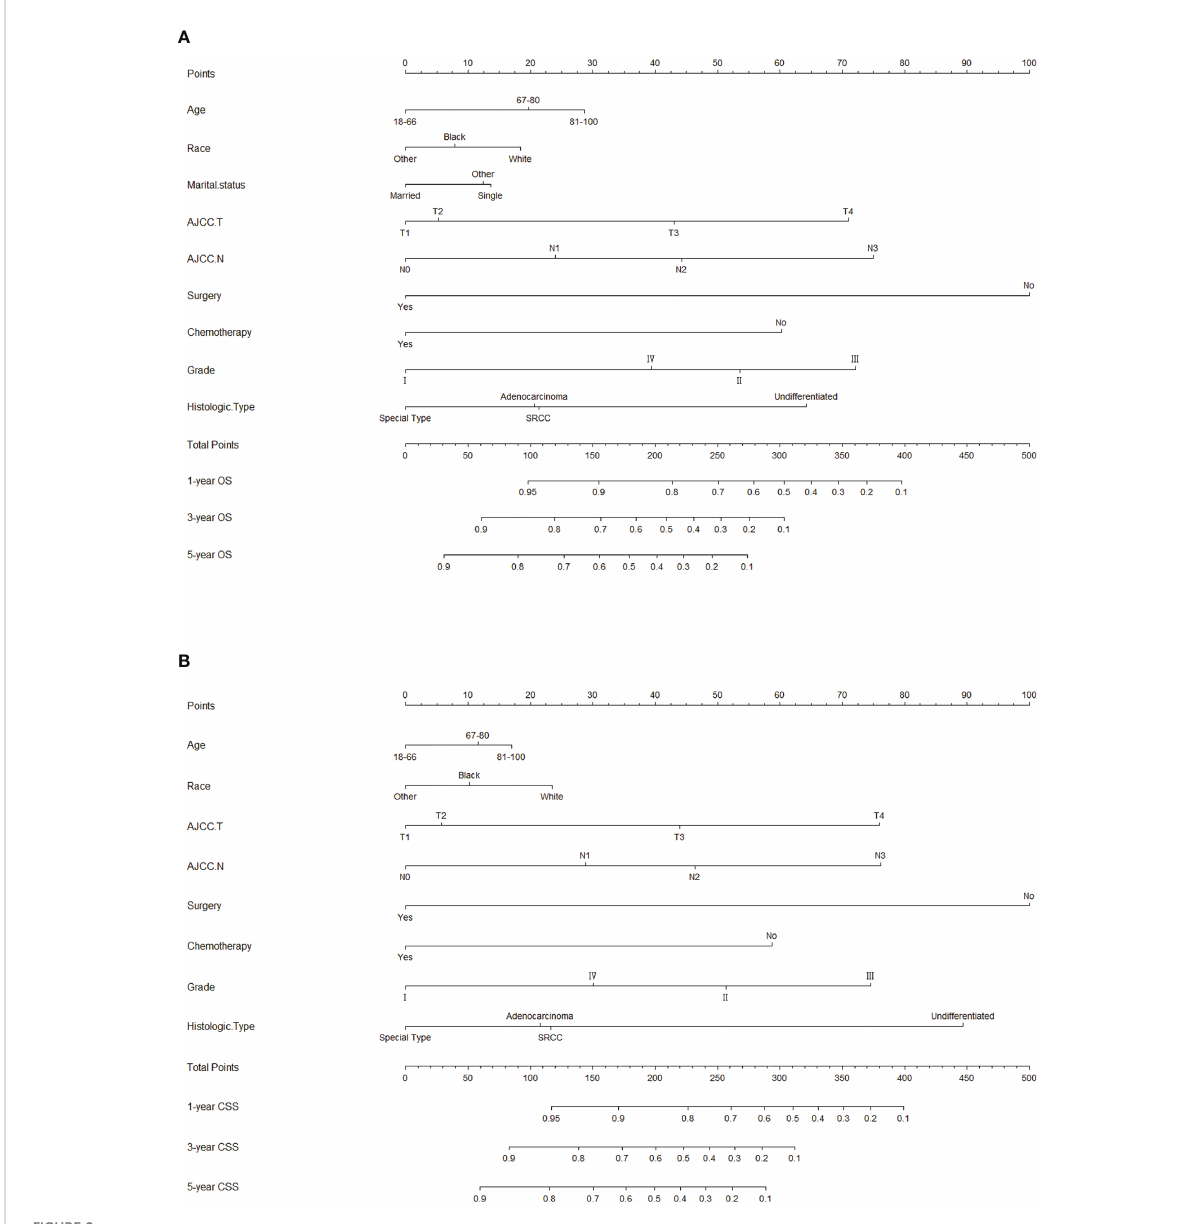
FIGURE 2 Nomograms for predicting 1-, 3-, and 5-year (A) OS and (B) CSS of patients with